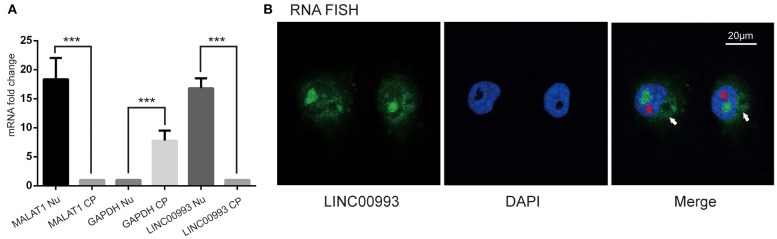
Location of LINC00993 in breast cancer cells. (A). Location of LINC00993 detected by qRT-PCR. Nuclear and cytosolic compartments of MDA-MB-231 cells were extracted. Nu means nuclear, CP means cytoplasm. ***P < 0.001, based on Student's t-test. Data were presented as mean ± SEM. (B). MDA-MB-231 cells were labeled with a LINC00993 probe via RNA fluorescence in situ hybridization (FISH) and counterstained with DAPI: 4',6-diamidino-2-phenylindole (DNA to visualize the nucleus). A representative image is shown.